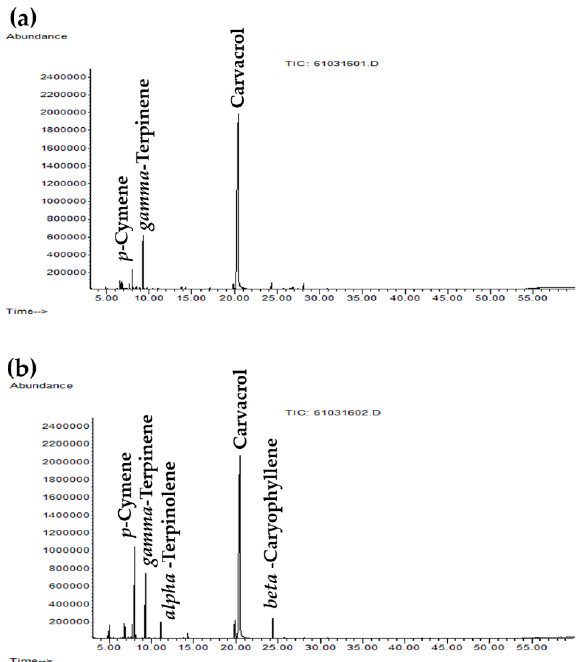
Figure 1. Gas chromatography–mass spectrometry (GC–MS) chromatograms of Highland O. vulgare oil from tropical region ( a ) and commercial O. vulgare from Mediterranean region ( b ).